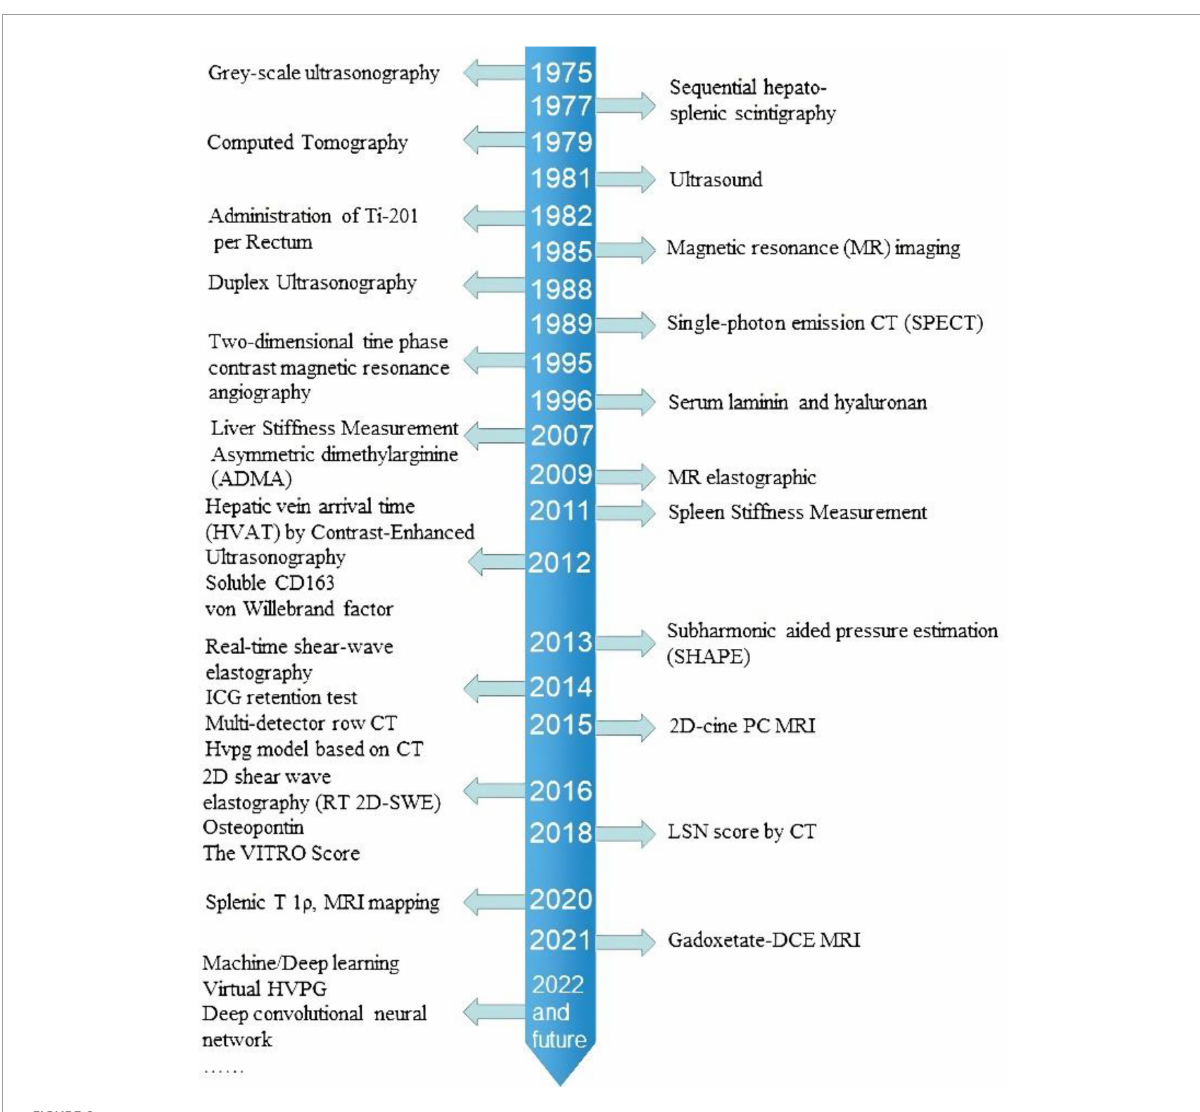
FIGURE6 Shows the occurrence time of different non-invasive detection of portal